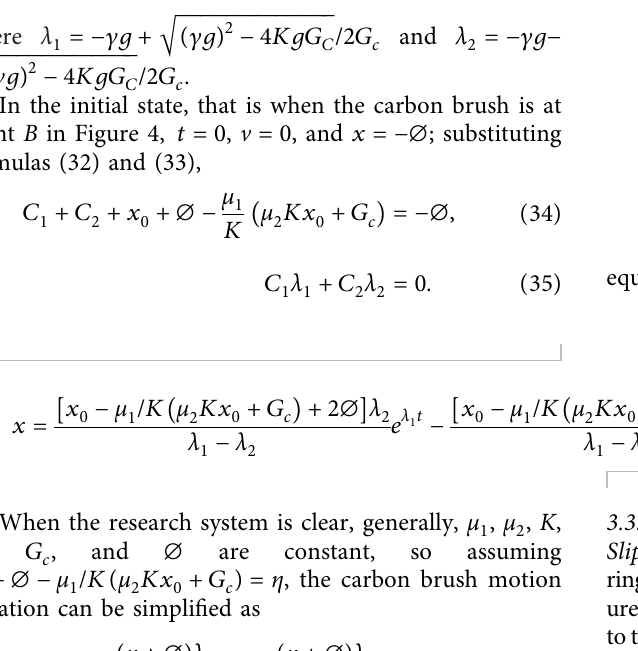
Figure 4: Carbon brush running track diagram in T /2